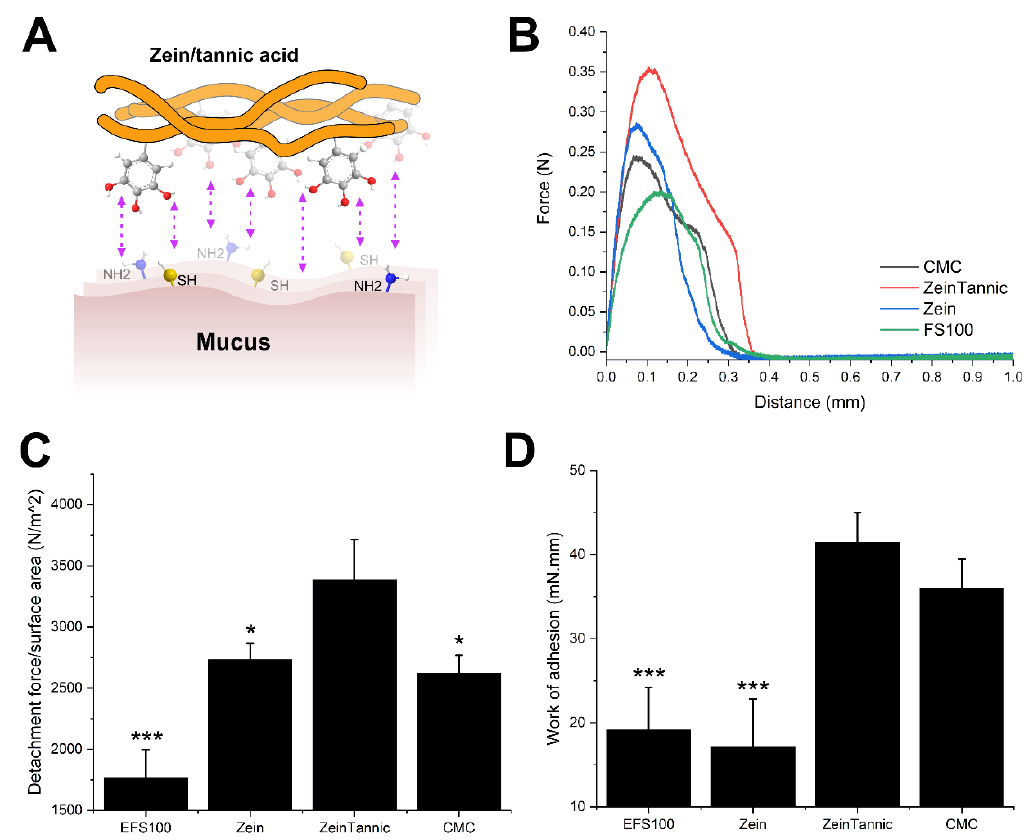
Figure 4. ( A ) Schematic representation of tannic-acid-mediated mucoadhesion of zein/tannic acid. ( B ) Representative force – displacement curves for the detachment of CMC, zein/tannic acid, zein and EFS100 from porcine intestinal mucus. ( C ) Detachment force of coated substrates obtained from force – displacement curves. ( D ) Work of adhesion of coated substrates calculated from force – displacement curves. Data are presented as mean ± SD, n = 4. Statistical significance is presented as * ( p ≤ 0.05), ** ( p ≤ 0.01), and *** ( p ≤ 0.001).